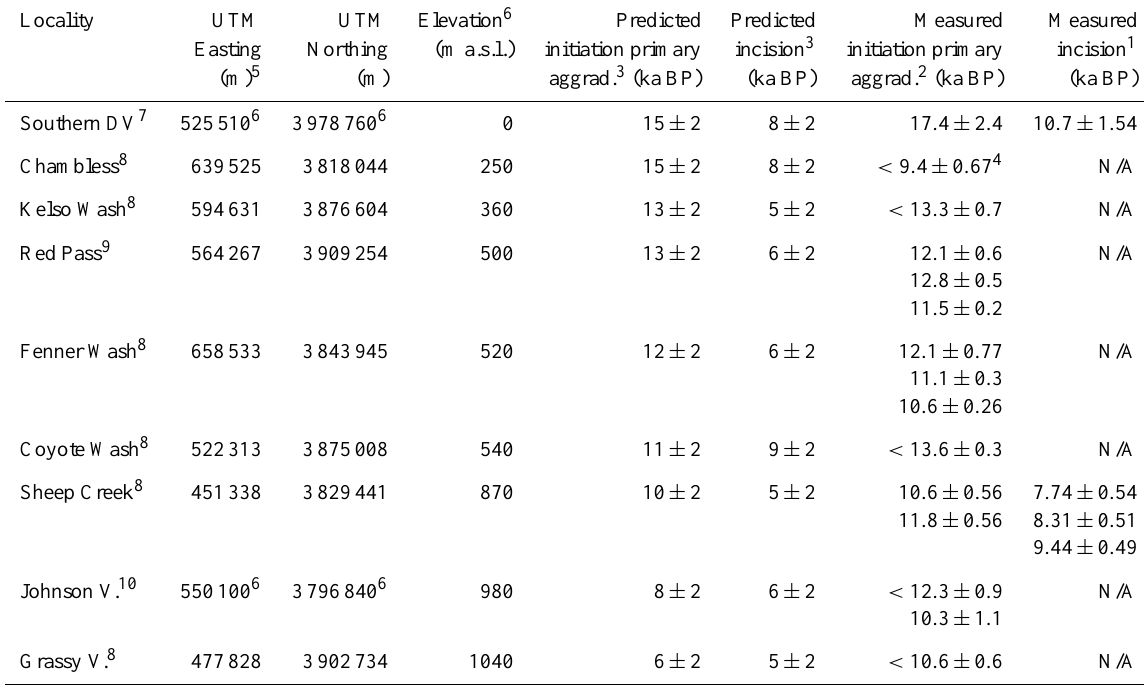
Table 1. Comparison of available data and model predictions for the timing of fluvial-system aggradation and incision from the latest Pleistocene to the present. Sites are listed in order of increasing elevation to highlight the relationship between elevation and the age of initiation of primary aggradation in the data and model (UTM – Universal Transverse Mercator; V. –